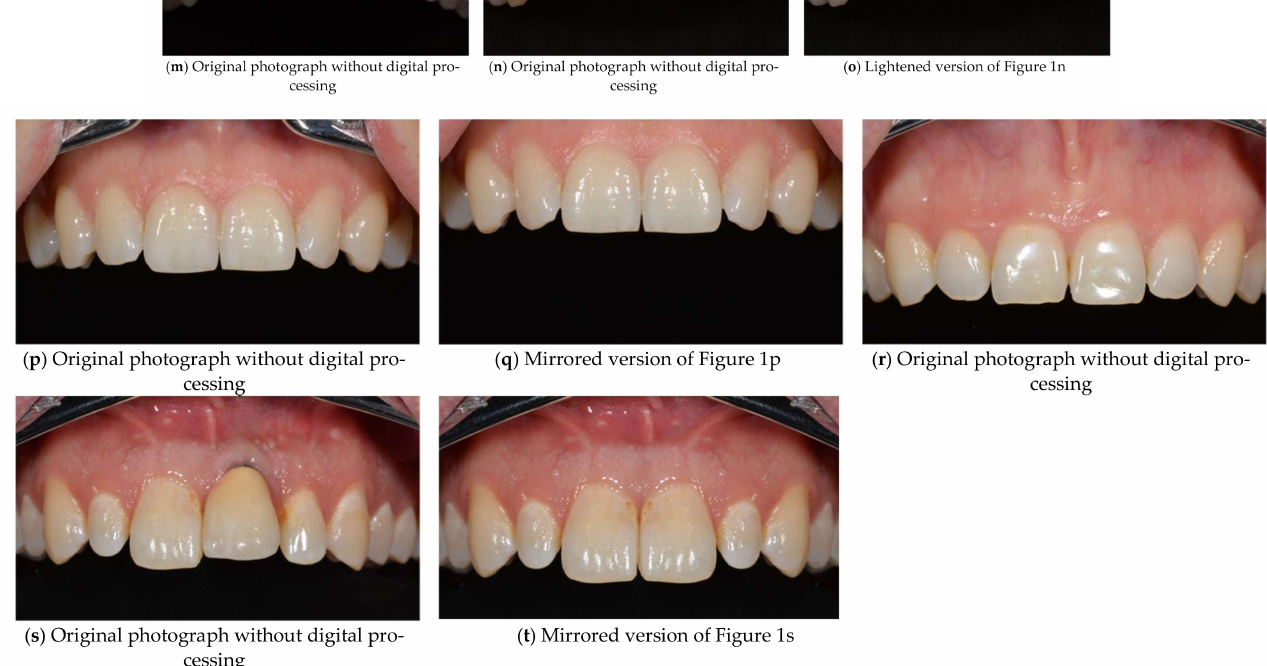
Figure 1. Images for viewing and evaluation by the